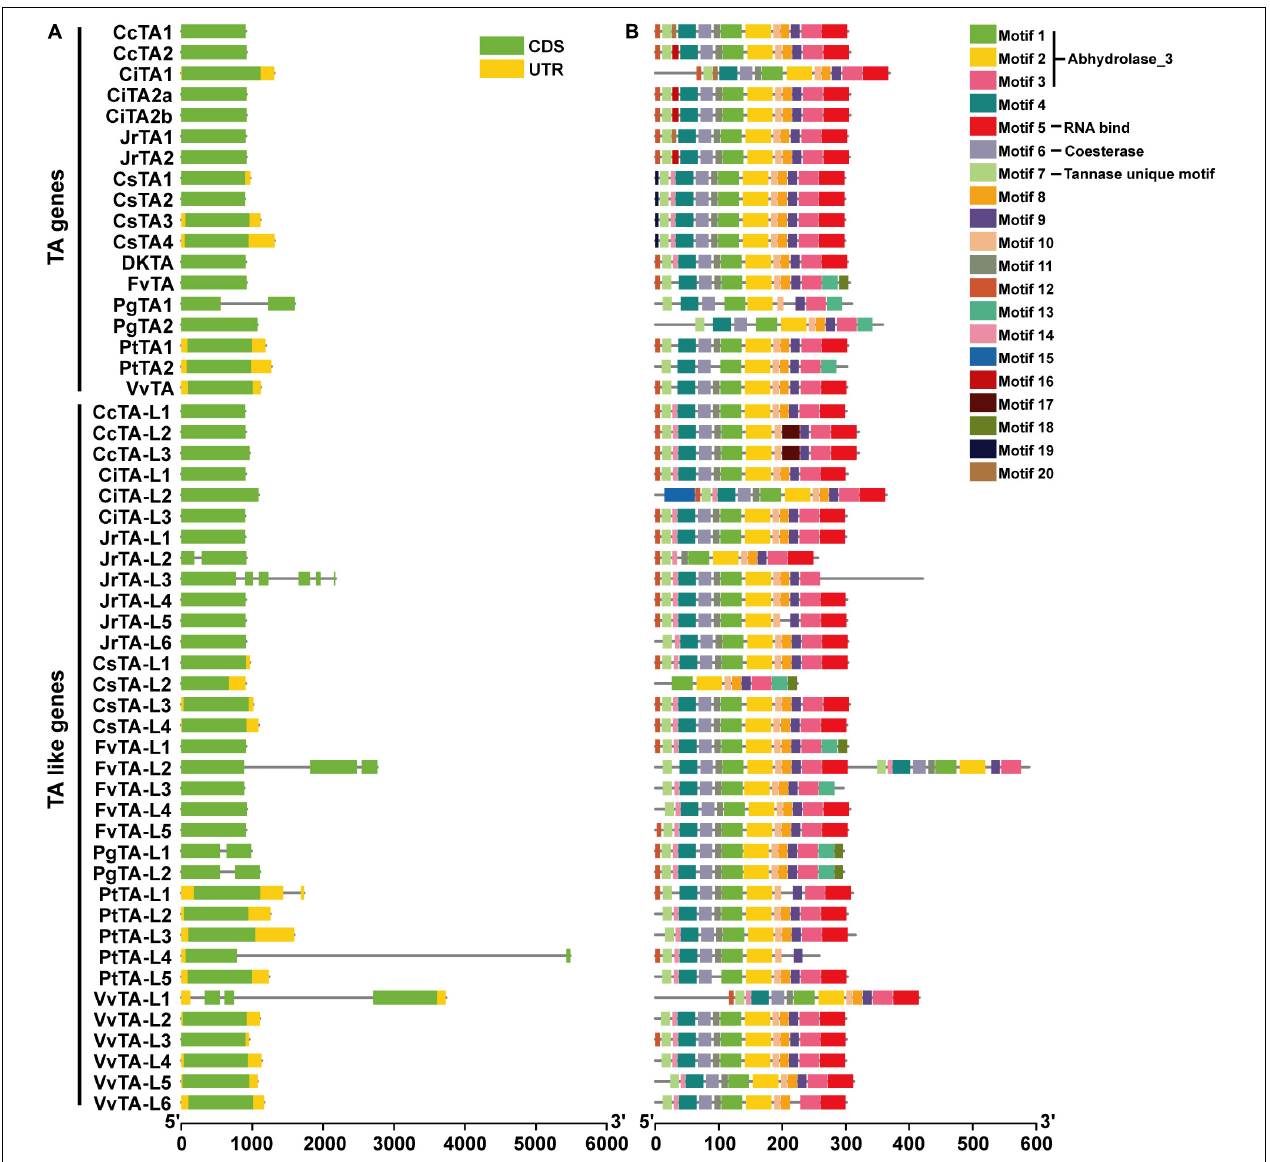
FIGURE 3 | Structure analysis of TA and TA -like genes in plants. (A) Exon–intron structures of TA and TA -like genes in 13 species. CDSs were shown as green boxes, introns were shown as thin gray lines, and UTRs are shown as yellow boxes. (B) Distribution of conserved motifs among proteins identified using MEME suite program. The motifs, numbered 1–20, were designated with a specific color. The sequence information for each motif was provided in Supplementary Table 3